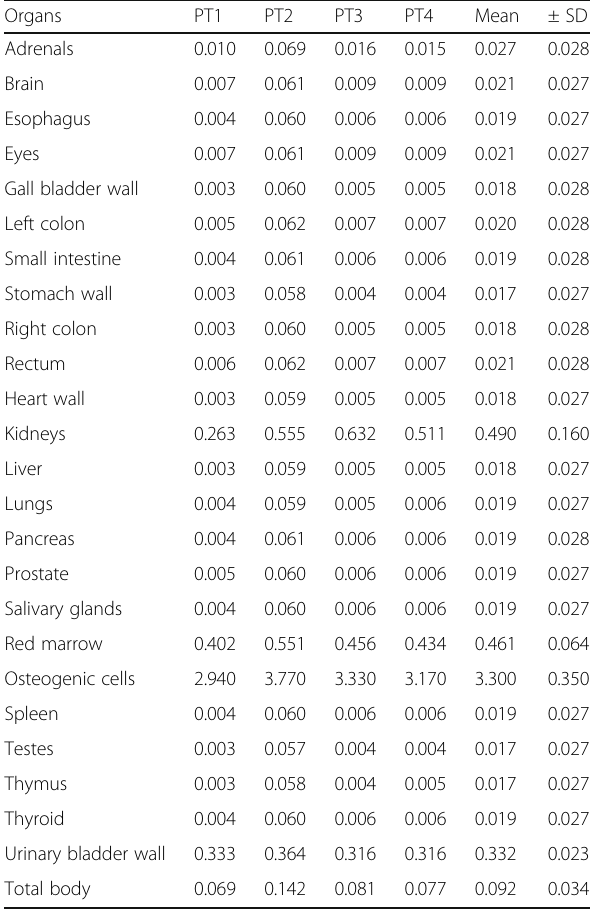
Table 3 Organ absorbed doses (mSv/MBq) of [ 177 Lu]Lu- DOTA ZOL